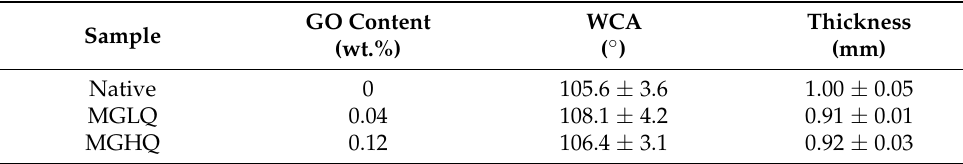
Table 4. Physical properties of the membranes.